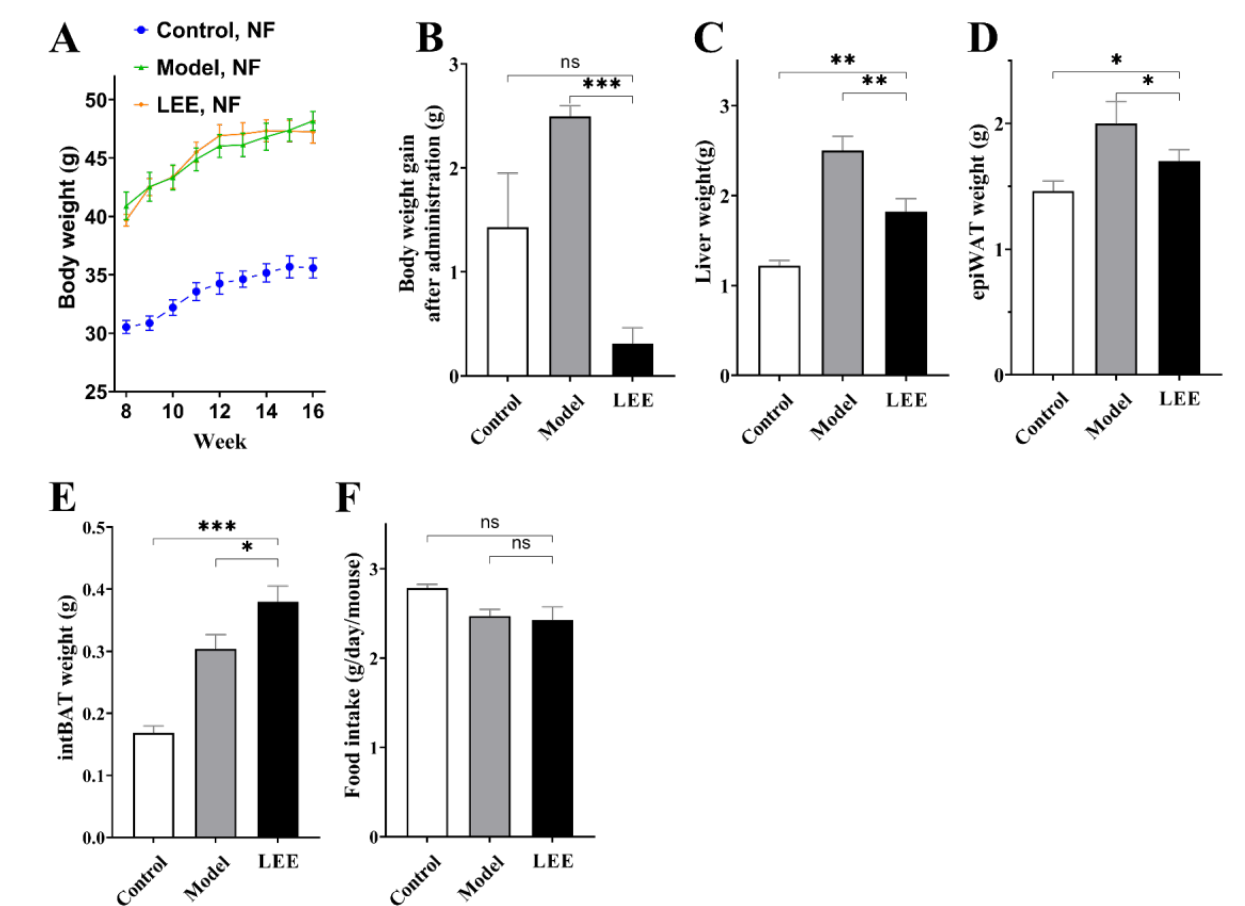
(Figure 1F), suggesting that the effects of LEE on body weight and obesity were independent of the changes in food intake.